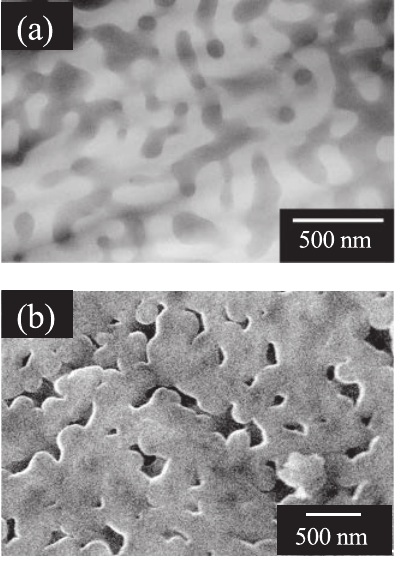
Fig. 6: Electron micrographs of glass F: (a) after heat treatment at 993 K for 96 h, (b) after leaching of two-phase glass with a 1 M HCl solution